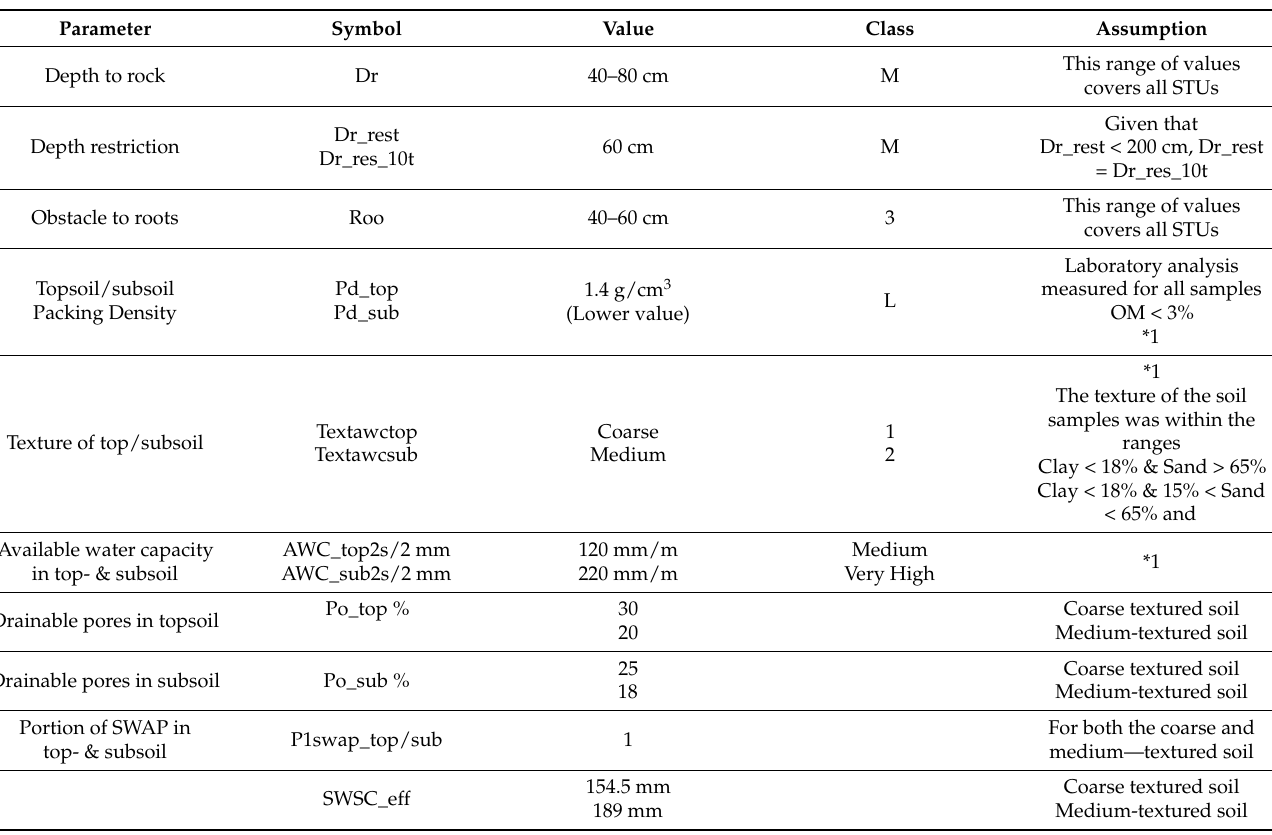
Table A4. The PESERA model SWSC